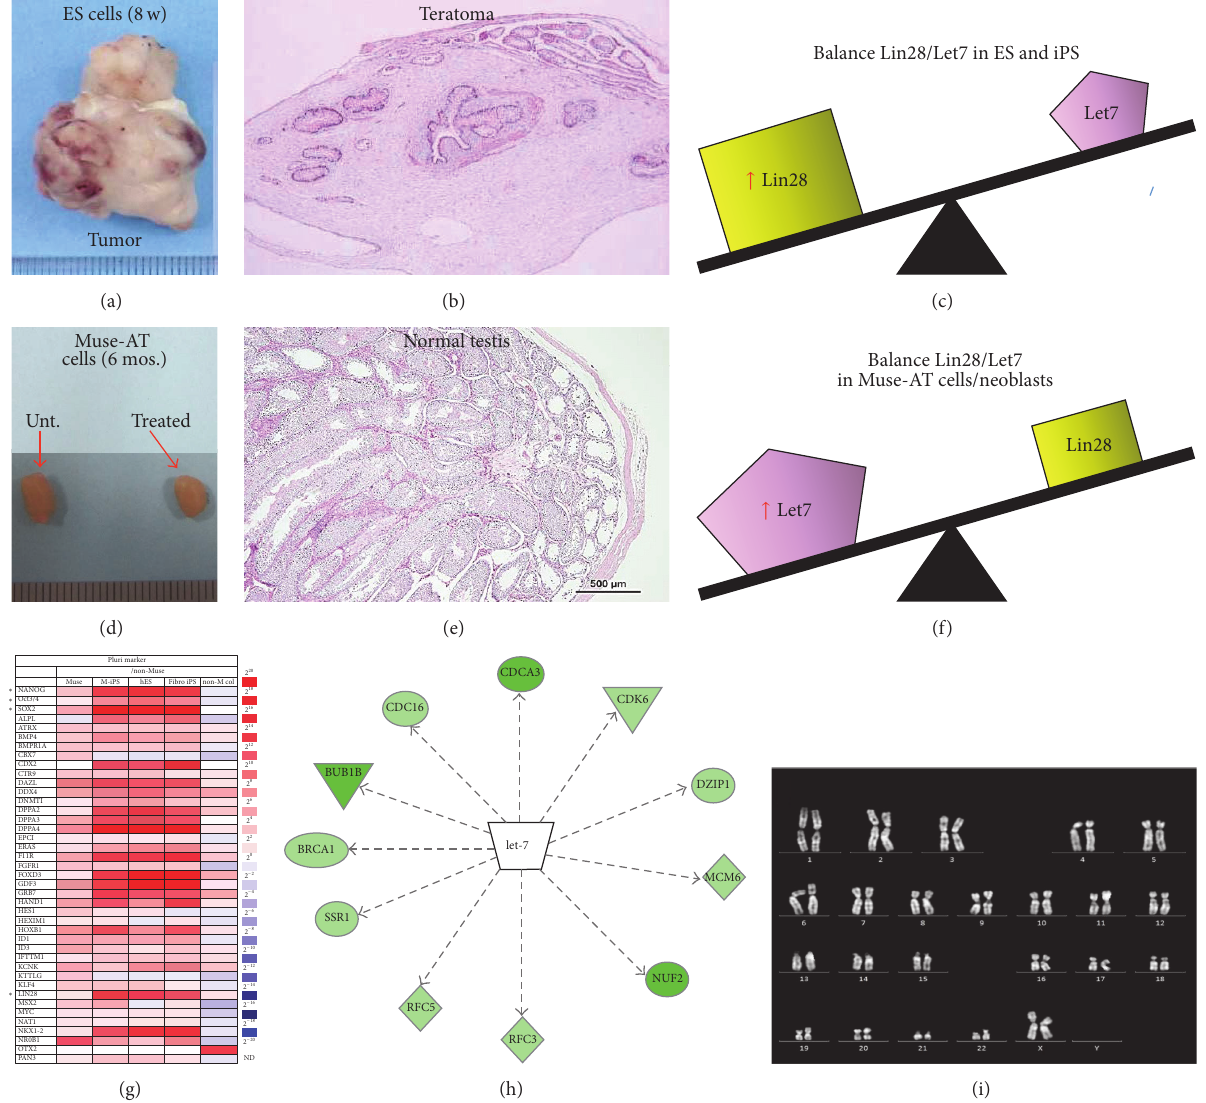
Figure 2: Properties of Muse-AT cells. Nontumorigenicity of Muse-AT cells. Embryonic stem (ES) cells injected into immunodeficient mice (SCID mice) testes, formed teratomas within 8 to 12 weeks (a). Histological analysis showed that the teratoma contained muscle tissue, intestine-like structure, and keratinized skin (b). Muse-AT cells transplanted into testes did not form teratomas even 6 months after injection, similar to untreated testes (d). Testis injected with Muse-AT cells maintained normal structure (e). Yin-Yang balance between Let7 and Lin28: ES and IPS expressed much higher levels of Lin28 versus Let7 (c). Muse-AT cells and neoblasts expressed much higher levels of Let7 versus Lin28 (f). Differences in expression of pluripotent stem cell genes between Muse cells, ES, iPS, and non-Muse cells determined by qRT-PCR (g). MicroRNA Let-7 is an upstream regulator of CDA3 , CDC16 , DZIP1 , SSR1 , RFC3 , RFC5 , MCM6 , NUF2 , BRCA1 , BUB1B , and CDK6 (h). Normal karyotype of human Muse-AT cells is indicated by 23 intact pair of chromosomes with a pair XX chromosome indicating female origin of the cells (i). (a)-(b) From Figure 3 : [6]. (g) From Table 1 [7]. ∗ indicates pluripotent stem cell